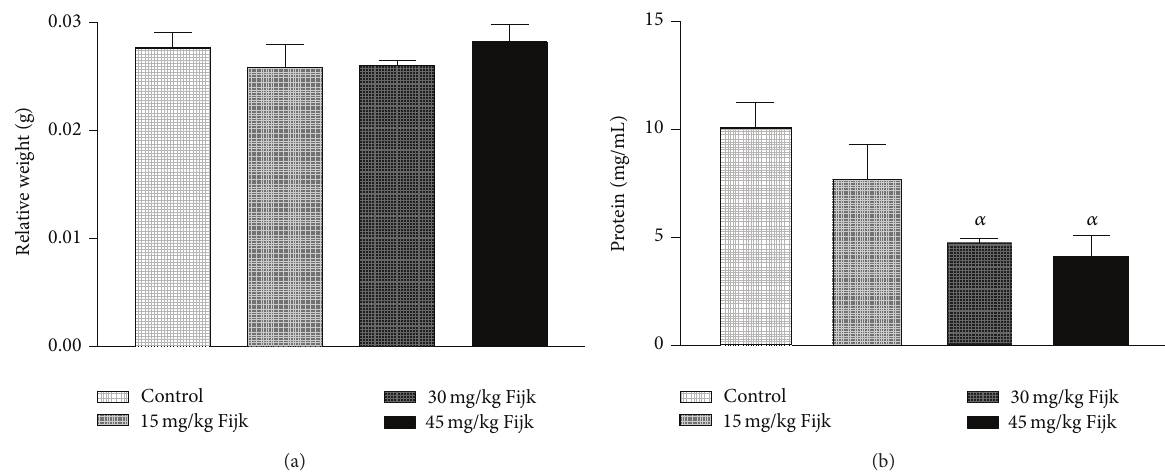
Figure 1: (a) Rat organ-to-body weight ratio following repeated and oral exposure to Fijk herbal at different dosages; (b) level of rat plasma protein following repeated and oral exposure to Fijk herbal at different dosages. Data are presented as mean value ± standard error of mean (SEM), 𝑛 = 6 . 𝛼 is significant at 𝑃 < 0.05 relative to control.